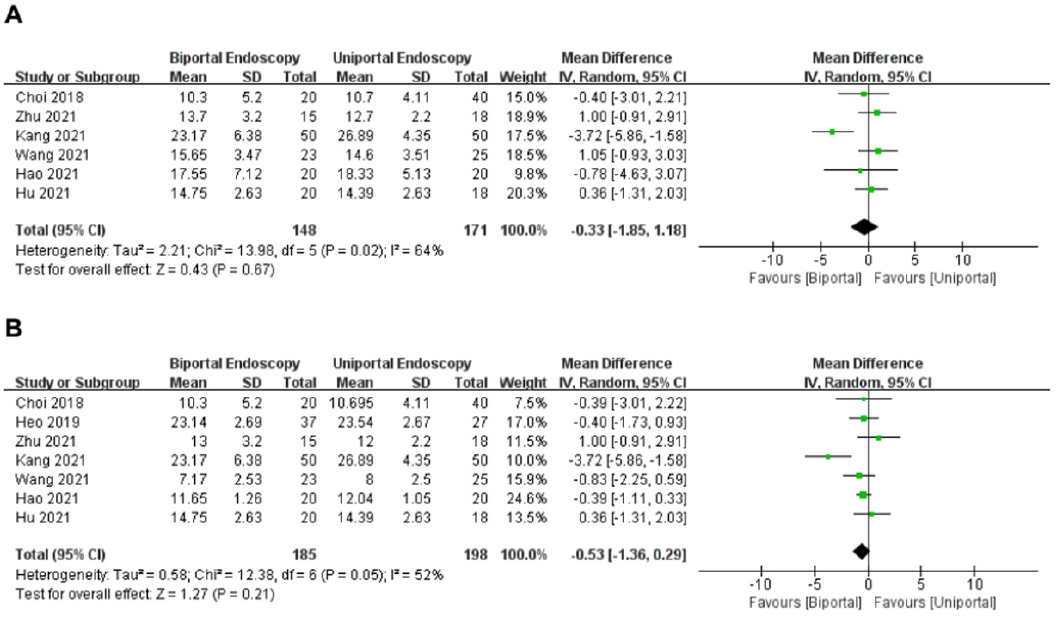
Figure 5. Forest plot of ODI ( A ) within 3 months; ( B ) last follow-up Choi et al., 2018 [15]; Heo et al., 2019 [16]; Zhu et al., 2021 [14]; Kang et al., 2021 [11]; Wang et al., 2021 [12]; Hao et al., 2021 [17]; Hu et al., 2021 [13].